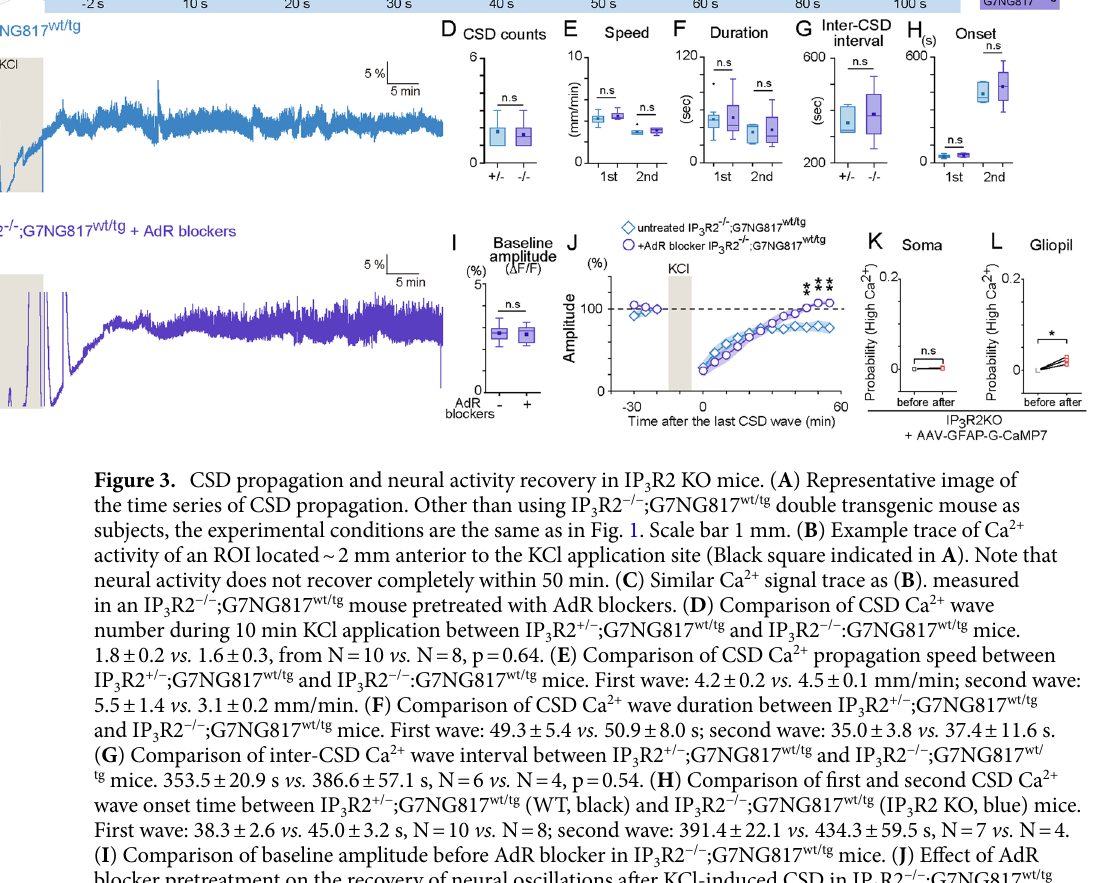
mice. Recovery is facilitated by AdR blocker pretreatment (N = 6) compared with the untreated control group (N = 6). ( K , L ) Comparisons of mean somatic and gliopil Ca 2+ probability in IP 3 R2 KO expressing G-CaMP7 in mice). *p <